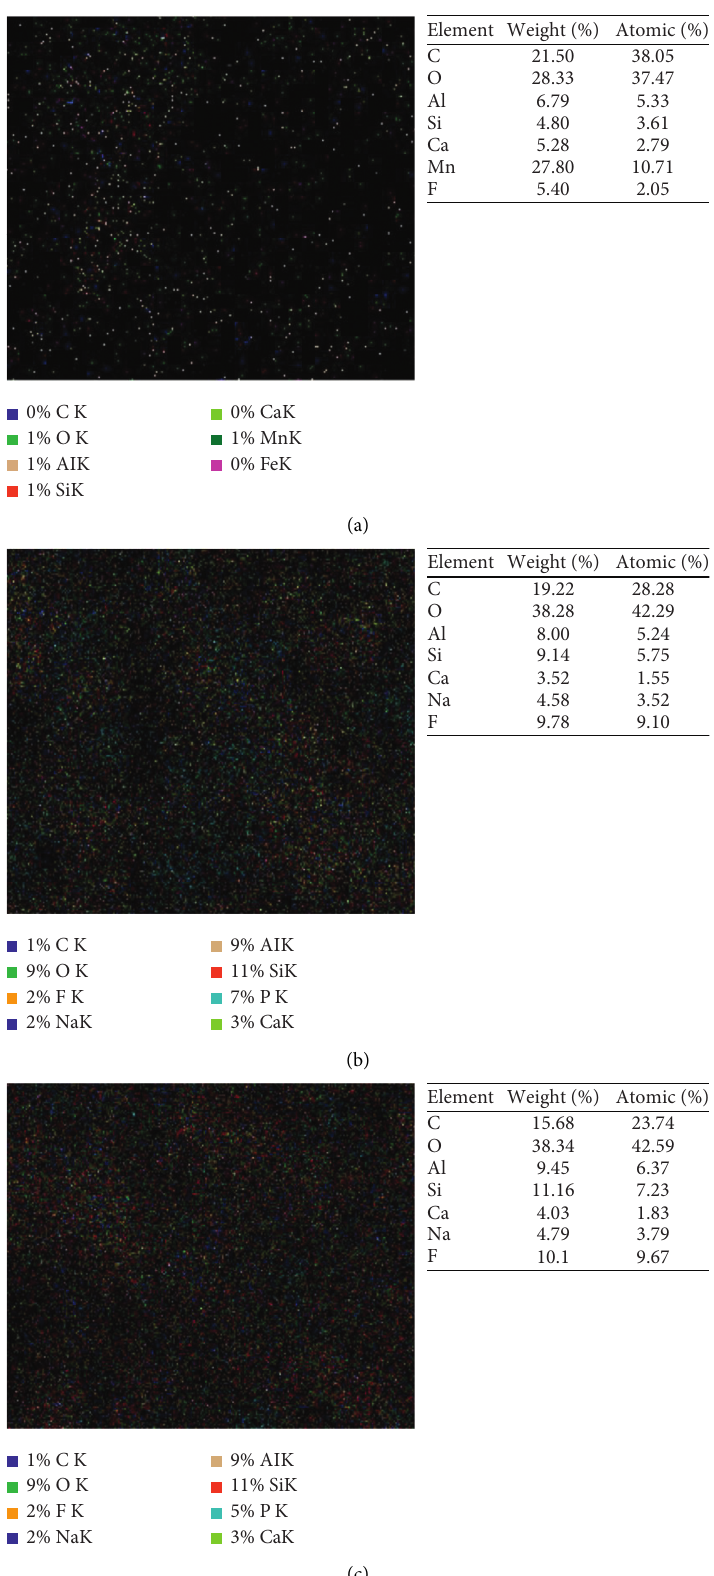
Figure 5: Mapping analysis of the main Amalgomer CR specimens before and after addition of different volume proportions of propolis. (a) Amalgomer CR. (b) Amalgomer CR with 25 v/v % propolis. (c) Amalgomer CR with 50 v/v %